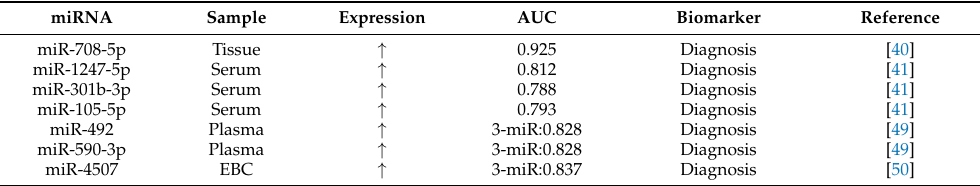
Table 1. MicroRNAs as biomarkers for diagnosis and prognosis of